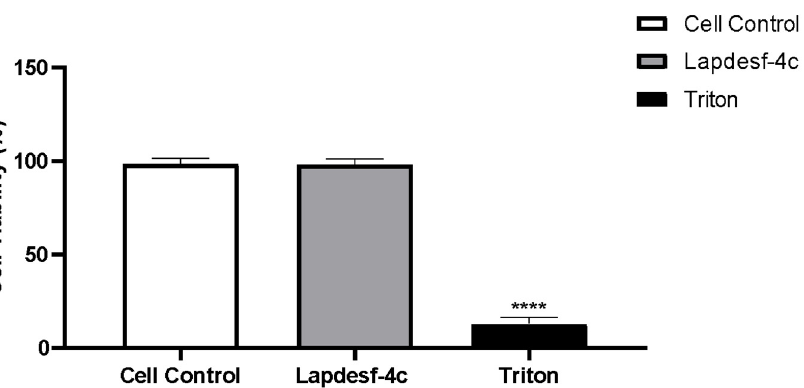
Figure 8. Cellular viability of HUVEC cells treated with Lapdesf-4c (200 µ M) and triton (1 µ M). **** p < 0.0001 compared to control and Lapdesf-4c .